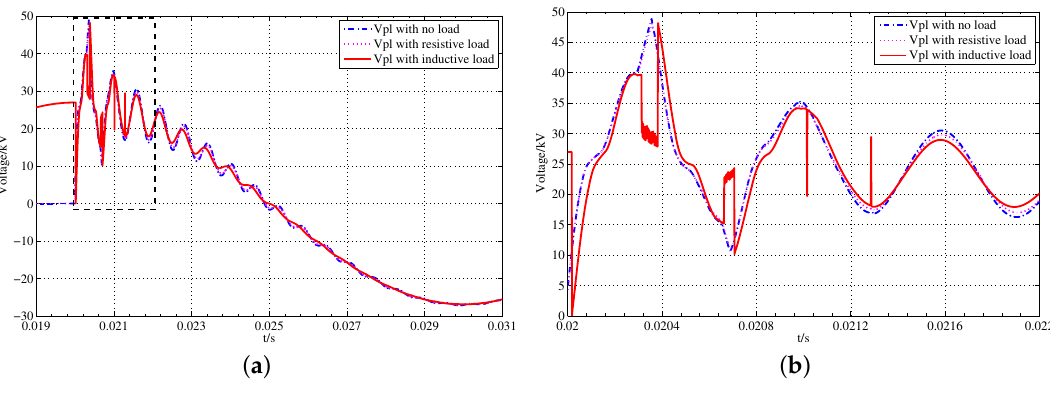
Figure 7. Result comparison of different load types: ( a ) result comparison; and ( b ) magnified